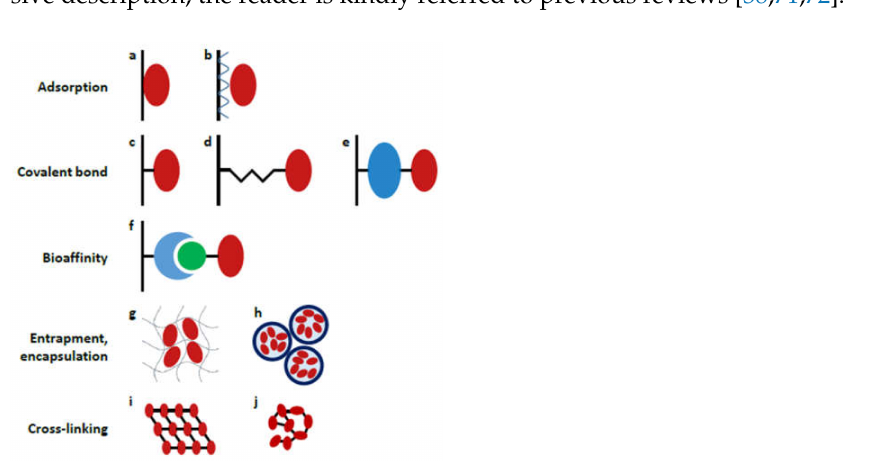
Figure 4. Schematic representation of different enzyme immobilization strategies: ( a ) direct adsorption, ( b ) layer-by-layer adsorption; covalent coupling ( c ) directly (e.g., EDC/NHS coupling), ( d ) through a short spacer (e.g., glutaraldehyde), ( e ) through a large spacer (e.g., albumin); ( f ) coupling by bioaffinity interaction (e.g., avidin-biotin interaction); ( g ) entrapment into a gel matrix, ( h ) encapsulation into polyelectrolyte capsules; cross-linking to form ( i ) ordered crystals or ( j ) unordered aggregates. (Reprinted with permission from [38], published by Elsevier (Amsterdam, The Netherlands),